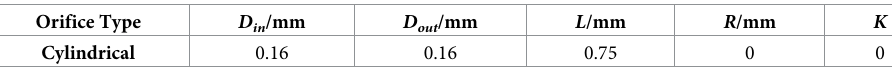
Table 1. The geometrical characteristics of the